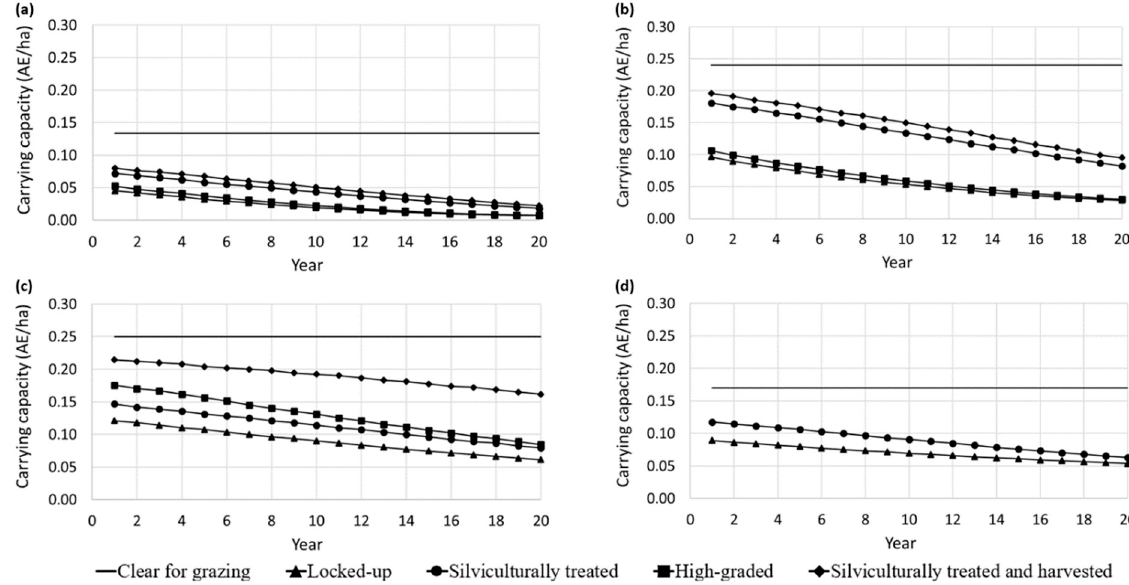
Figure 4. Projected cattle carrying capacity in regrowth forest between 2019 (year 1) and 2038 (year 20). ( a ) Glenbar, ( b ) Gayndah, ( c ) Doughboy, and ( d ) Rathdowney.